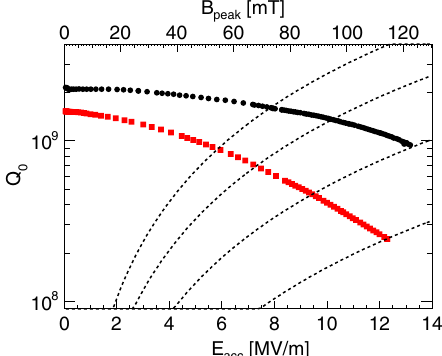
FIG. 8. Maximum peak magnetic field in Nb = Cu cavities was achieved when the trapped magnetic field was minimized to 5 μ T. The circle points show 2.4 K and square ones show 4.5 K. The constant power lines are shown as guidelines, and are 5 W, 10 W, 25 W, and 80 W from